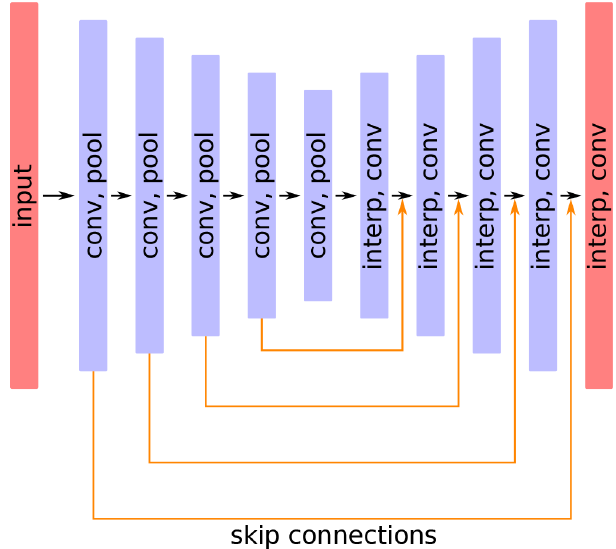
Figure 1. General structure of the DINCAE with 2D convolution (conv), max pooling (pool) and interpolation layers (interp). All 2D convolutions are followed by a RELU activation function.